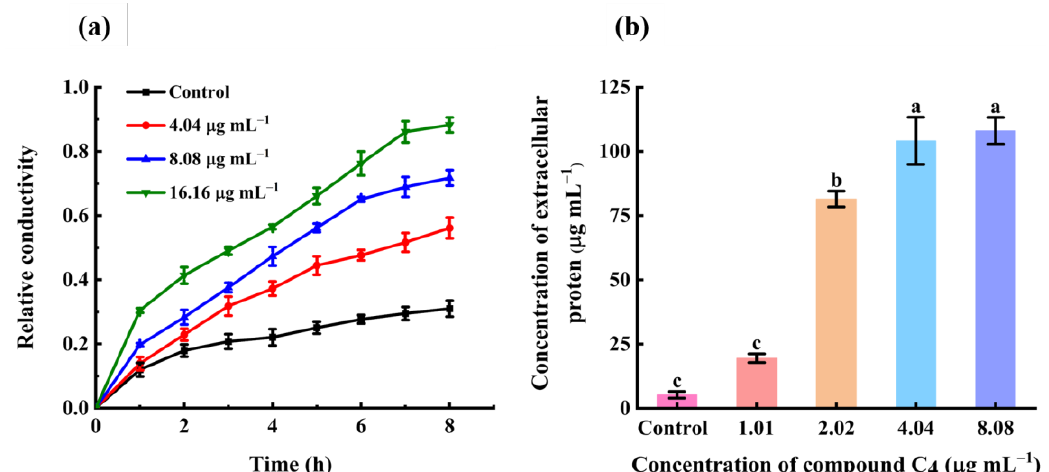
Figure 8. ( a ) Relative conductivity of Xoo cells treated with C 4 (Control, 4.04, 8.08, and 16.16 µg mL − 1 ). ( b ) Extracellular protein leakage in Xoo cells treated with C 4 (Control, 1.01, 2.02, 4.04, and 8.08 µg mL − 1 ). Bars indicate the mean ± SD. Lowercase letters indicate significant differences between the different treatment groups, as calculated using one-way ANOVA ( p < 0.05).